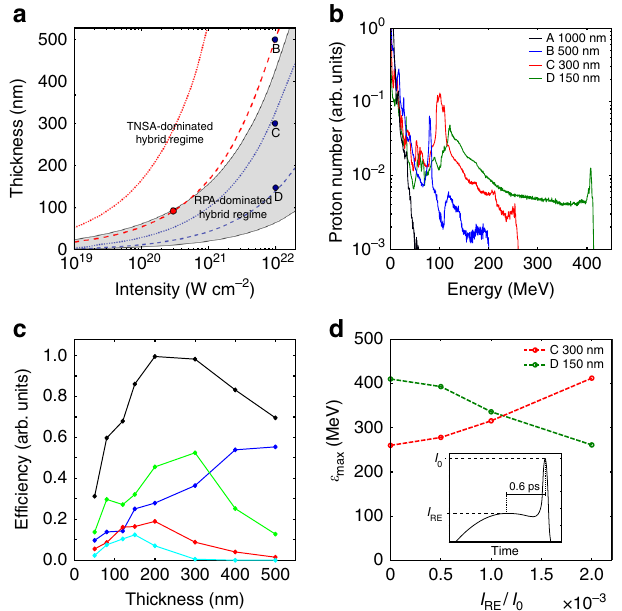
Fig. 9 Modelling and simulation results for multi-petawatt scale laser parameters. a ‘ (cid:3) I L parameter space for the TNSA- and RPA-dominant hybrid regimes, for plastic 18 . Scaling of the maximum ‘ for which RIT occurs (dotted) and optimum ‘ for which RIT occurs near the peak of the pulse (dashed) with I L , for pulse durations τ L = 900 fs (red) and τ L = 40 fs (blue). The red point corresponds to ‘ opt in the experiment. The blue points labelled B, C and D correspond to example cases discussed in the main